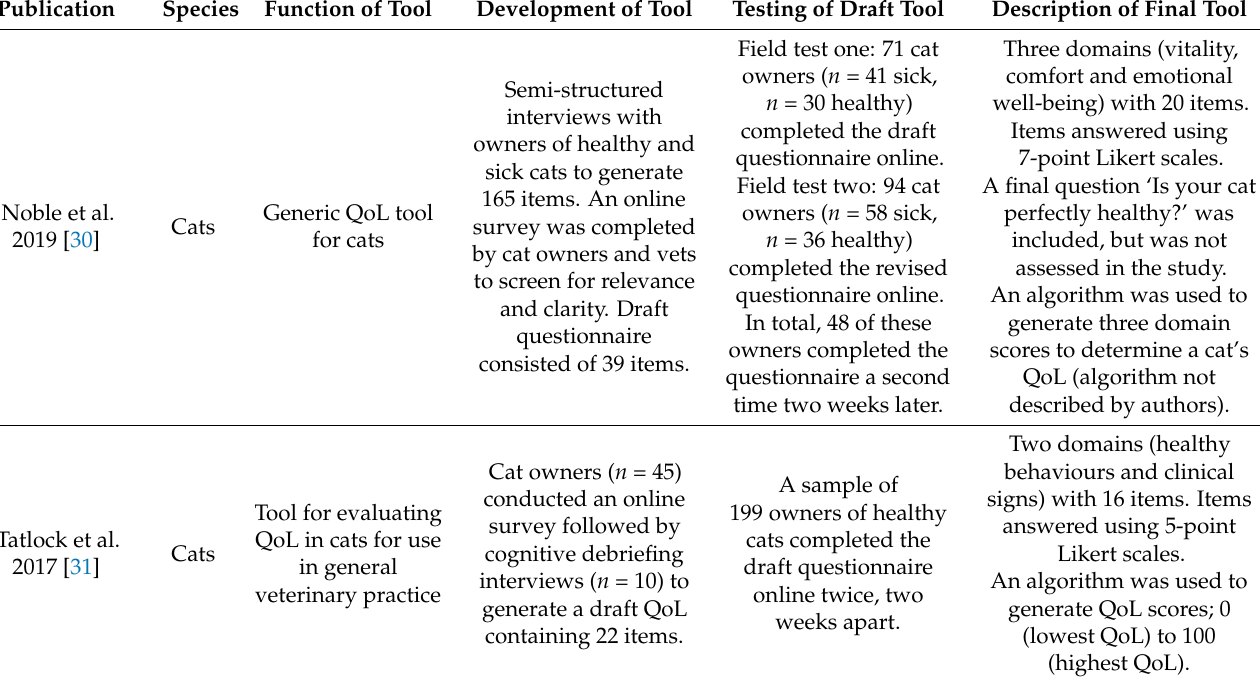
Table 2. Summary of information extracted from the nine published QoL tools (continued on following